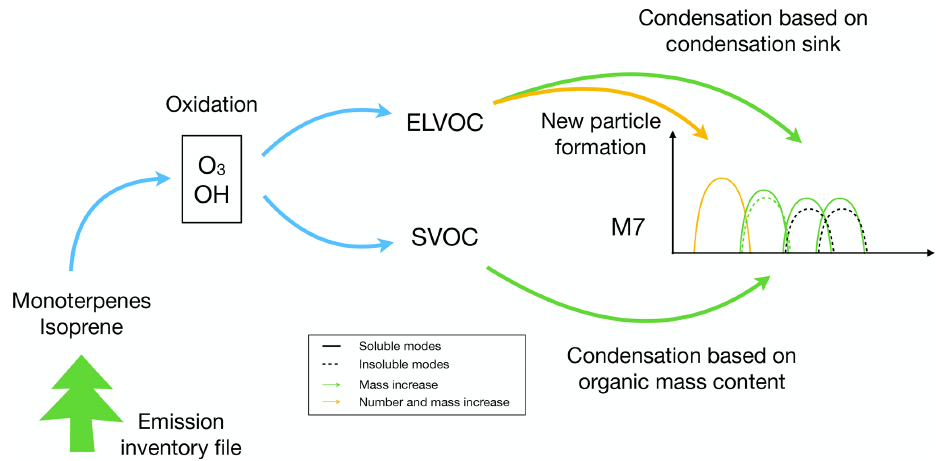
Figure 1. Schematic of the SOA formation scheme. Isoprene and monoterpenes are emitted from vegetation (read from emission file). Oxidation by OH and O 3 produces two organic surrogate species (ELVOC, SVOC). The lower-volatility product ELVOC participates in new particle formation and can condense on the existing particles according to particle surface area. The semi-volatile product SVOC can condense on existing particles according to their total OA mass.